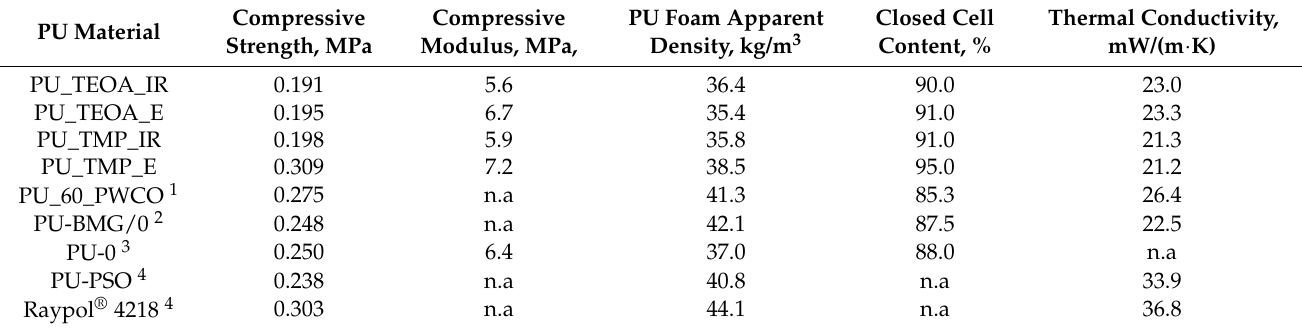
Table 5. The common characteristic of developed rigid PU foams comparison with other materials. PU Material